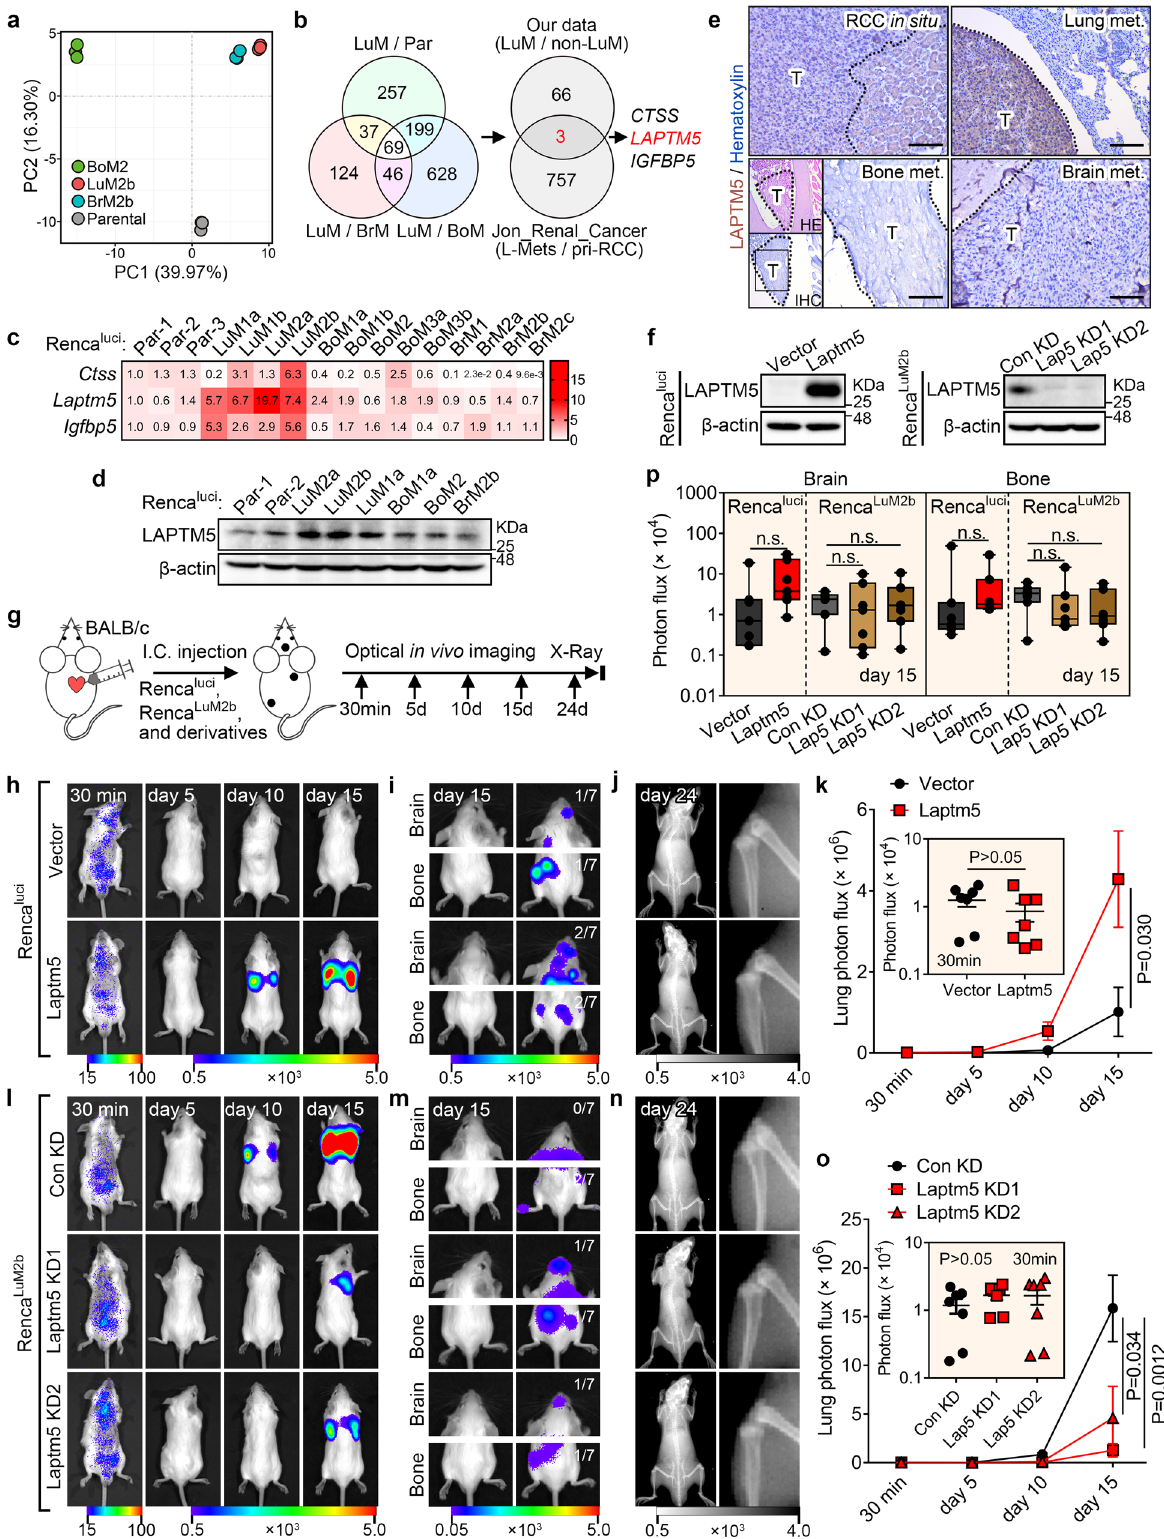
LAPTM5 overexpression did not enhance the ability of Renca luci cells to in fi ltrate the lung (Supplementary Fig. 4g), but accelerated the formation of both micro-metastases (maximum diameter < 100 μ m) and macro-metastases (maximum diameter > 100 μ m) since day 7 (Fig. 3b – d). On the contrary, silencing of Laptm5 suppressed the metastatic outgrowth of Renca LuM2b cells in the lung